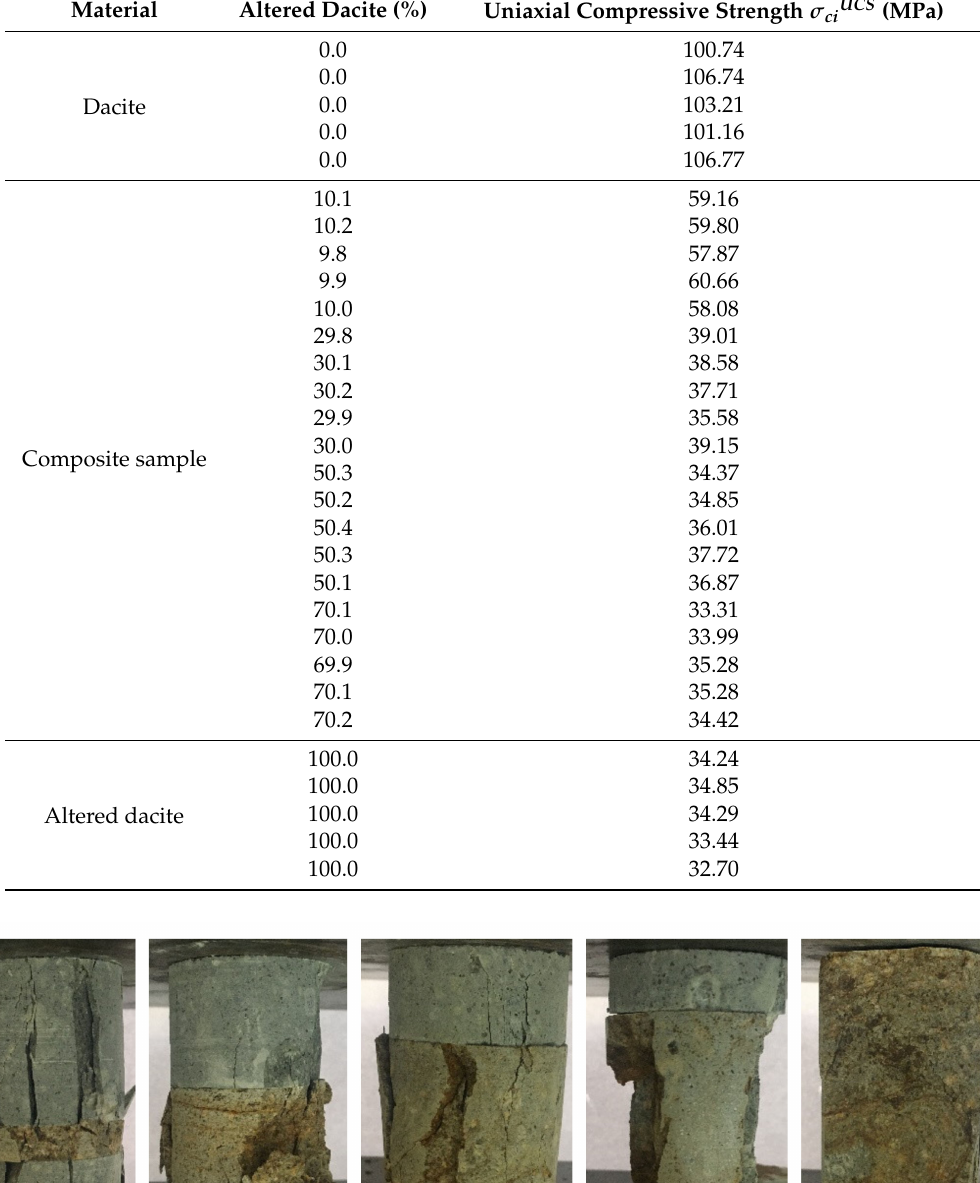
Table 1. Test results of UCS.